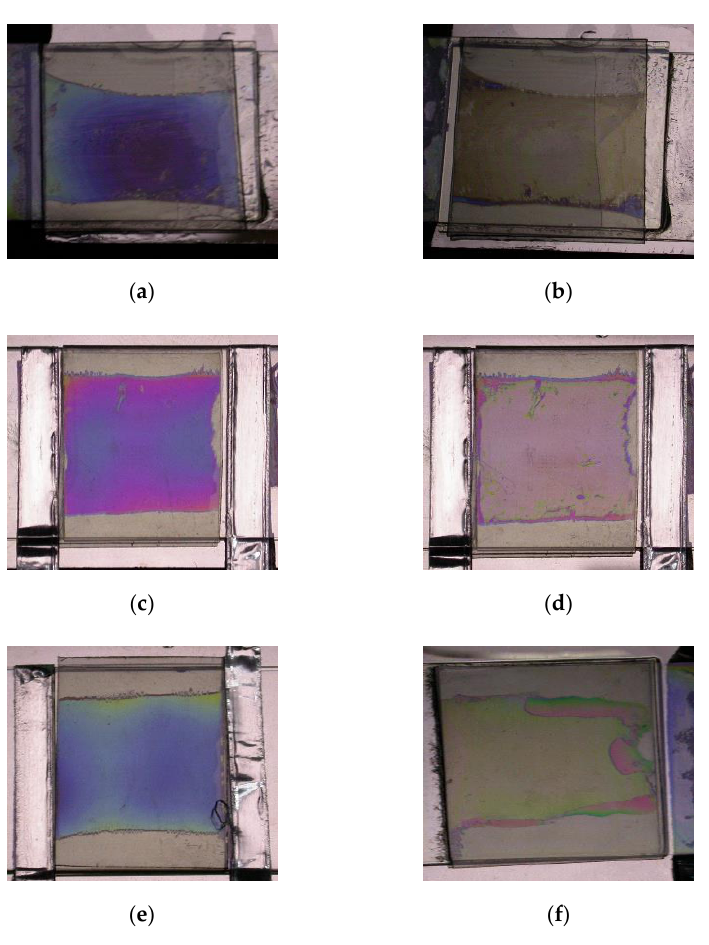
Figure 8. Fabricated BCSN devices with various retardation values. ( a ) splay state of 137.5 nm, ( b ) twist state of 137.5 nm, ( c ) splay state of 412.5 nm, ( d ) twist state of 412.5 nm, ( e ) splay state of 687.5 nm, and ( f ) twist state of 687.5 nm.